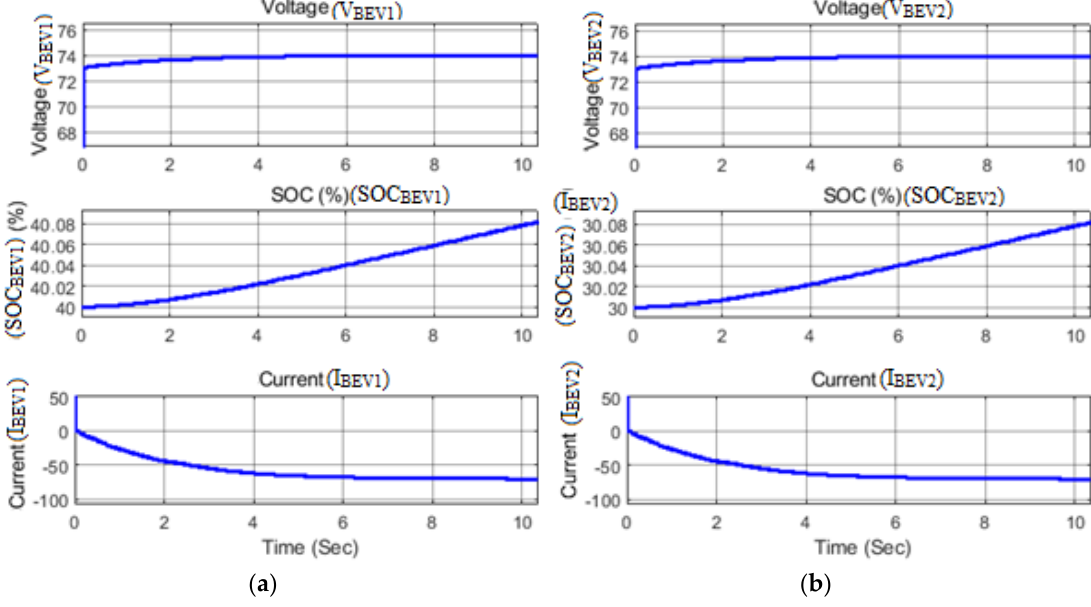
Figure 14. Battery characteristics while charging for electric vehicles ( a ) EV1 and ( b ) EV2.